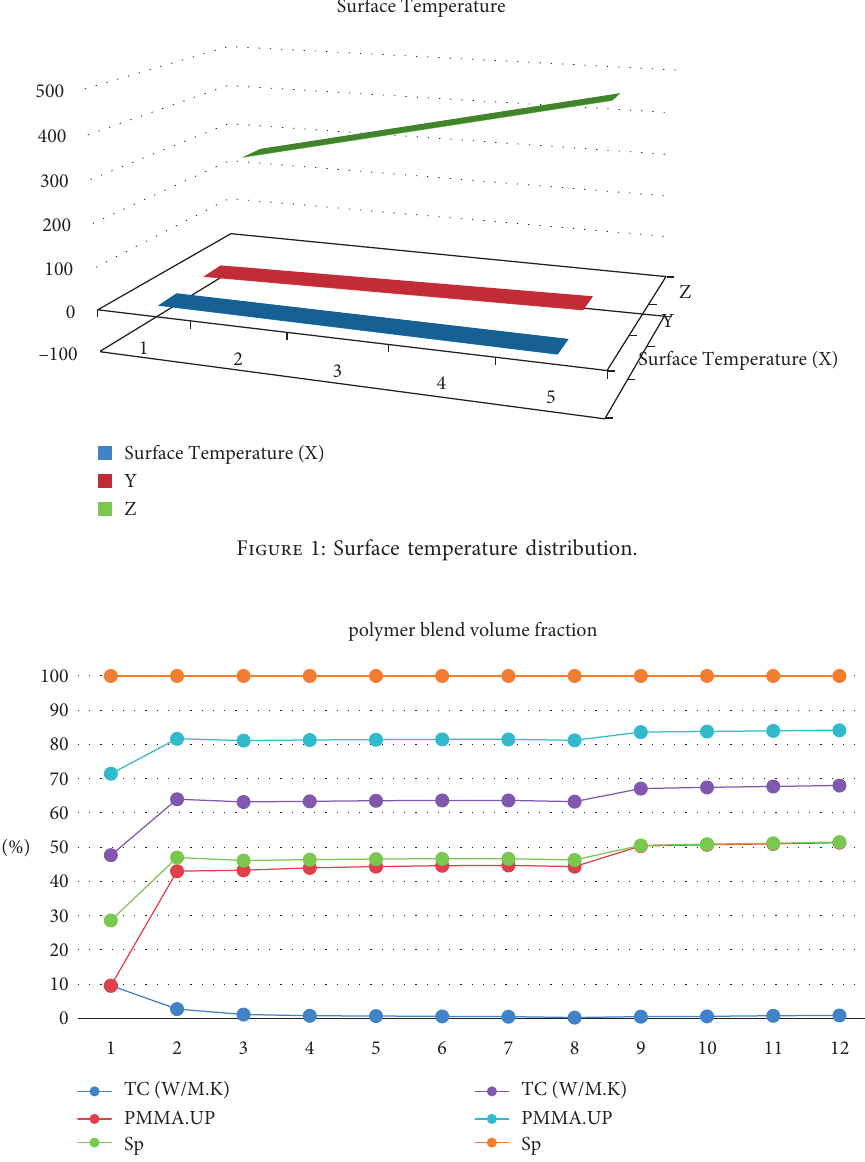
Figure 2: Polymer blend volume